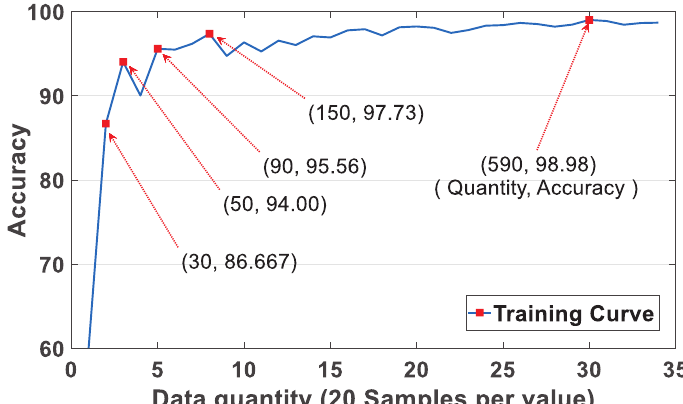
Figure 16. Training accuracy by different data